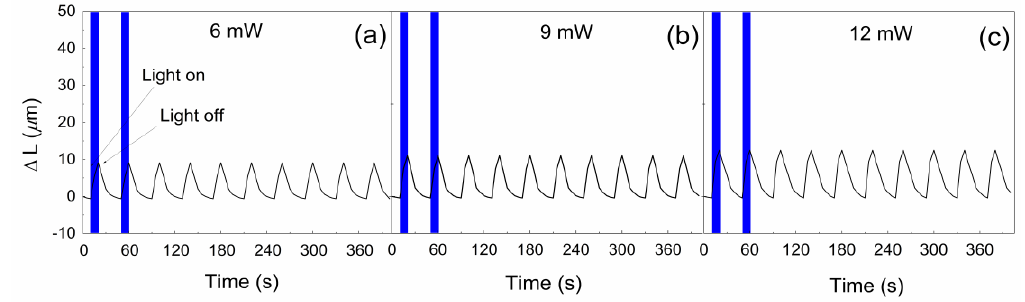
Figure 11. Photo-actuation performance of GO/PDMS composite at ( a ) 6 mW; ( b ) 9 mW; and ( c ) 12 mW irradiation intensity.